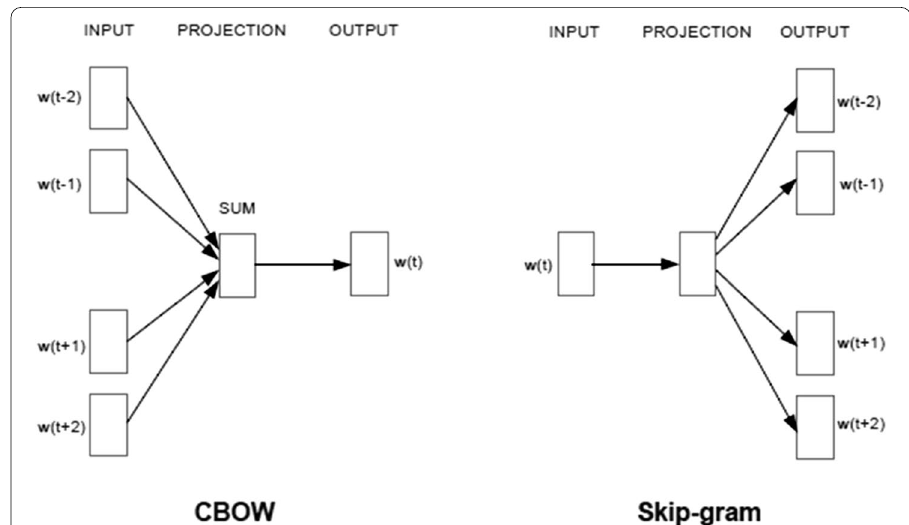
Fig. 11 Graphical representation of word2vec. Note The flowchart is borrowed from the original paper of Mikolov et al. (2013). It depicts the mechanism underpinning the two sub-algorithms of word2vec,CBOW and Skip-gram. In CBOW, the network learns w n , the word at position n , by virtue of its predecessors w n − 2 and w n w n w n − 1 as well as successors + 1 and + 2 . Skip-Gram reverses the process in CBOW, that is, with neural network predicts the surrounding words ( w n − 2 , w n − 1 , w n + 1 , w n + 2